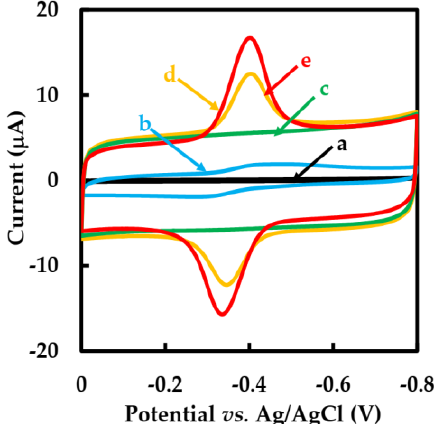
Figure 4. CVs of different modified GCEs: ( a ) bare GCE, ( b ) NF-GLA/GOD/GCE, ( c ) NF-GLA/MWCNTs-BSA-HFs/GCE, ( d ) NF-GLA/BSA-HFs-GOD/GCE, and ( e ) NF-GLA/MWCNTs-BSA-HFs-GOD/GCE in N 2 -saturated 50 mM phosphate-buffered solution (pH 6) at a scan rate of 0.05 V · s − 1 . CVs of NF-GLA/MWCNTs-BSA-HFs-GOD/GCE at different scan rates in N 2